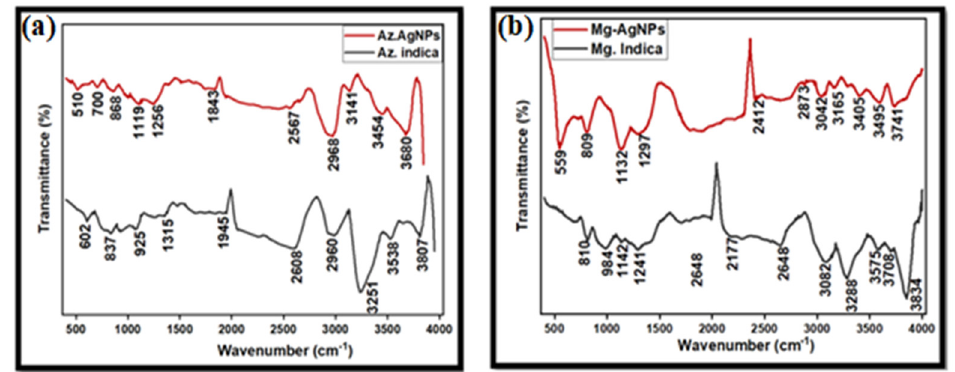
Figure 10. FTIR spectra of biosynthesized ( a ) A-AgNPs and ( b ) M-AgNPs using A. indica and M. indica extract at 70 °C.